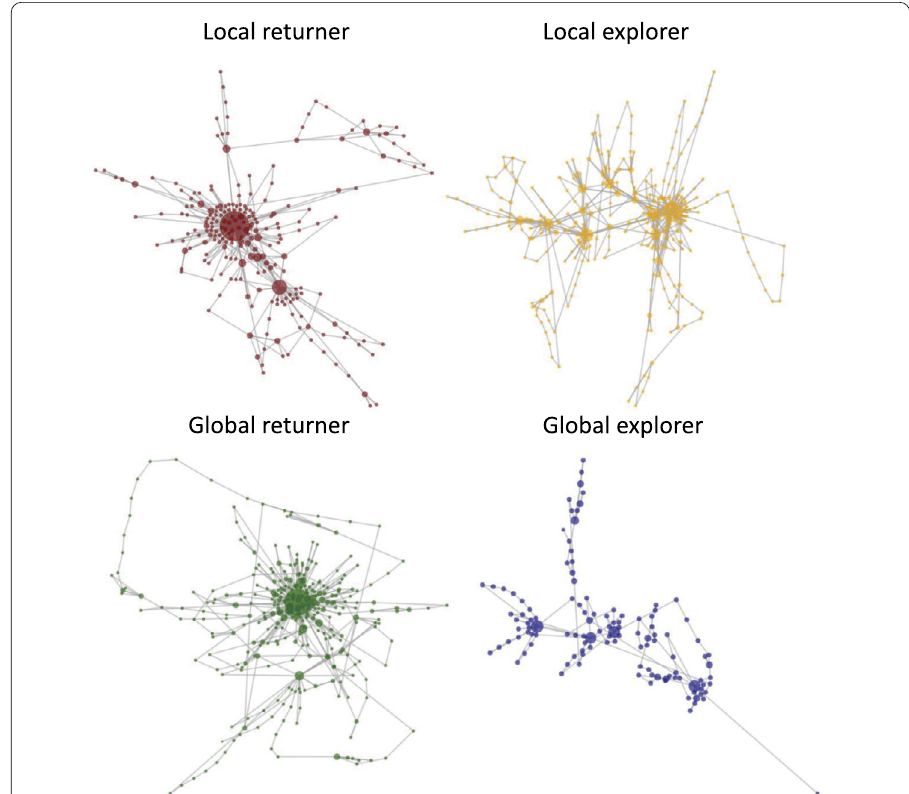
Figure 5 Network visualisation of four representative individuals from each behavioural group. Each node represents one visited location. The diameter of the node is proportional to the node